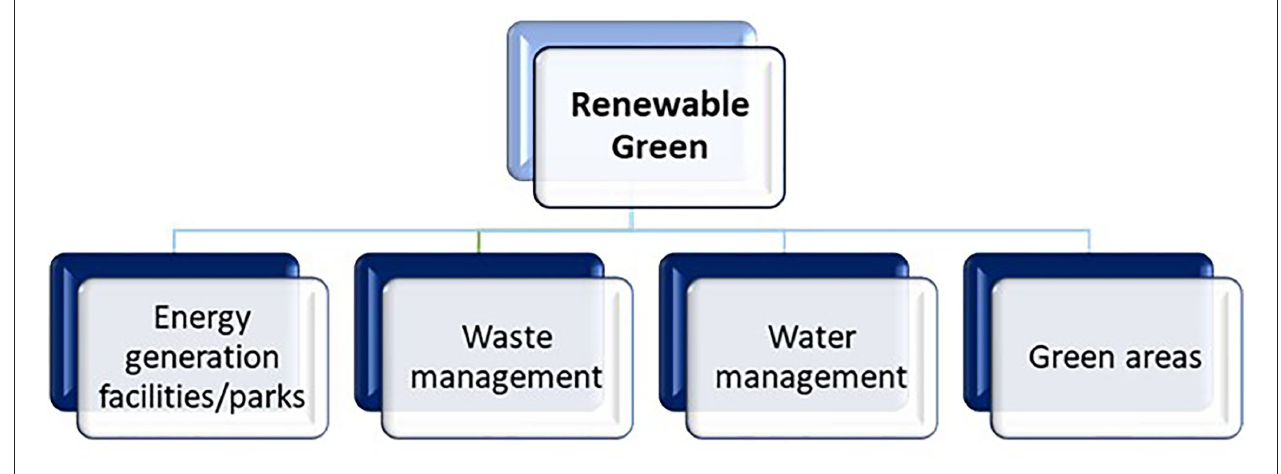
FIGURE 1 | Key pillars of airports’ environmental